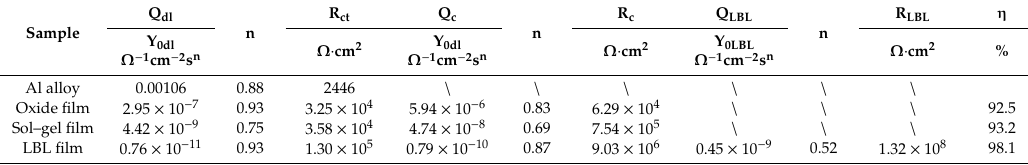
Figure 7. Equivalent models of EIS plots for Al alloy samples with different films. Table 1. Fitting results of EIS for Al alloy with different films.